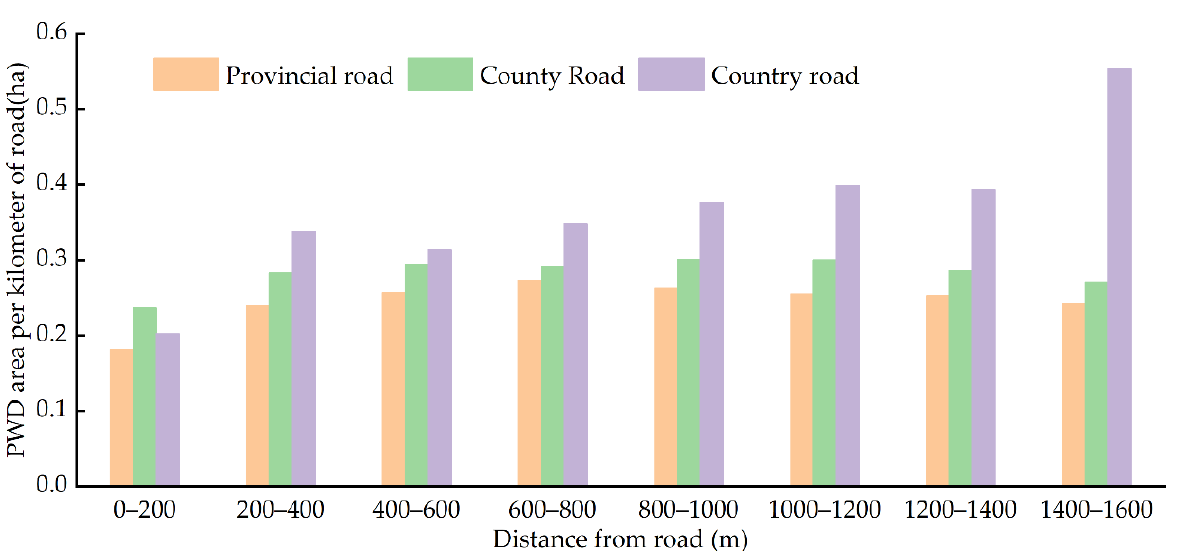
Figure 12. Relationship between occurrence area of PWD per unit length of road and distance of road in 2020.